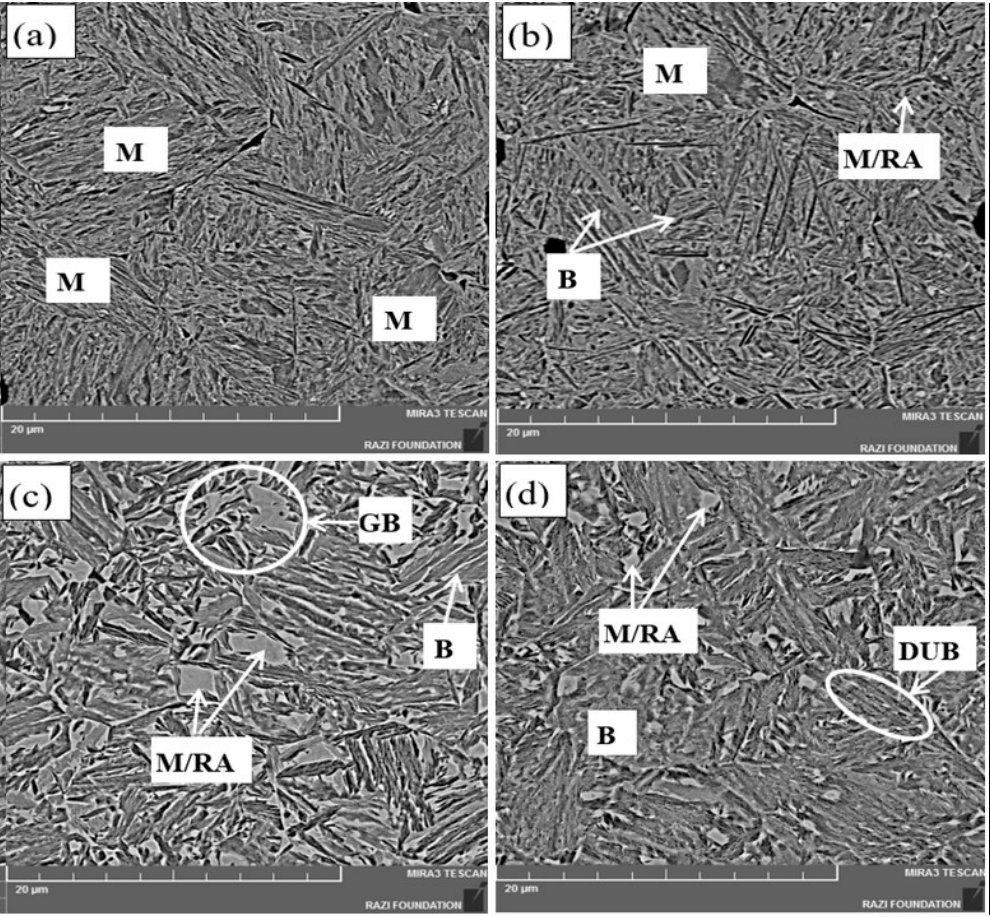
Figure 4. The backscattered electron micrographs of samples isothermally held at 350 °C for: ( a ) 5 s; ( b ) 30 s; ( c ) 200 s; ( d ) 1h, after following with room temperature water quenching.